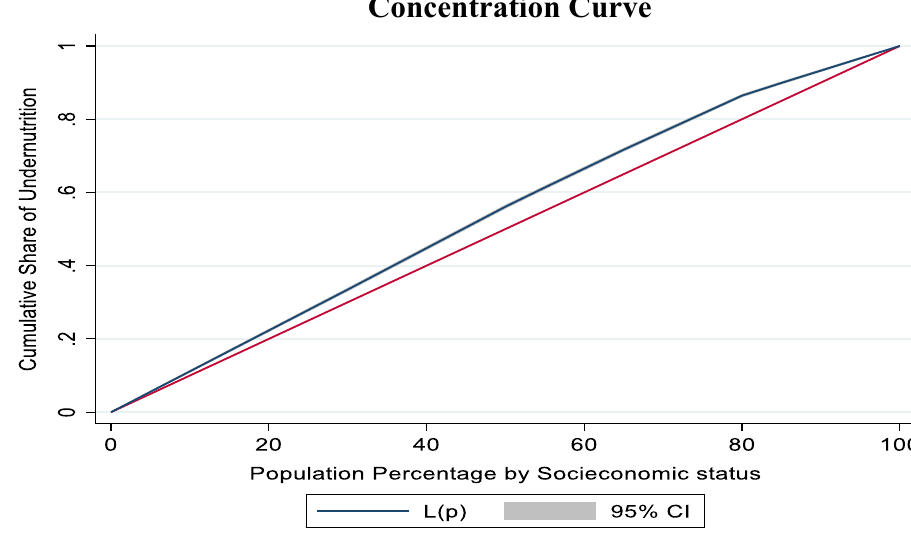
Fig. 1 Concentration curve of childhood